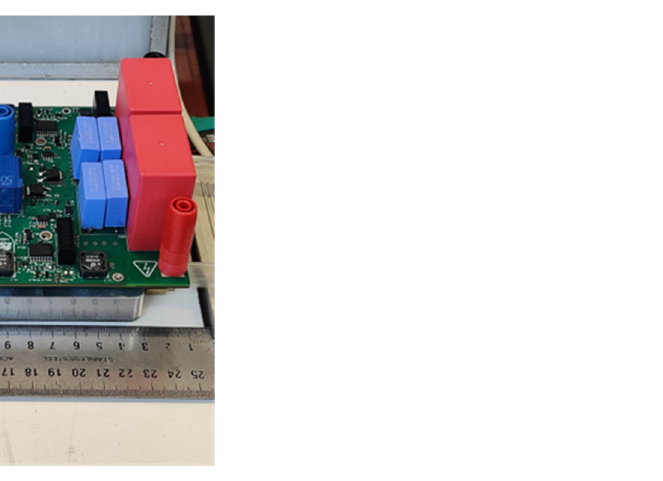
Figure 8. Three-phase SiC MOSFET inverter under test with a water-cooled cooling plate. Ruler scale in cm.